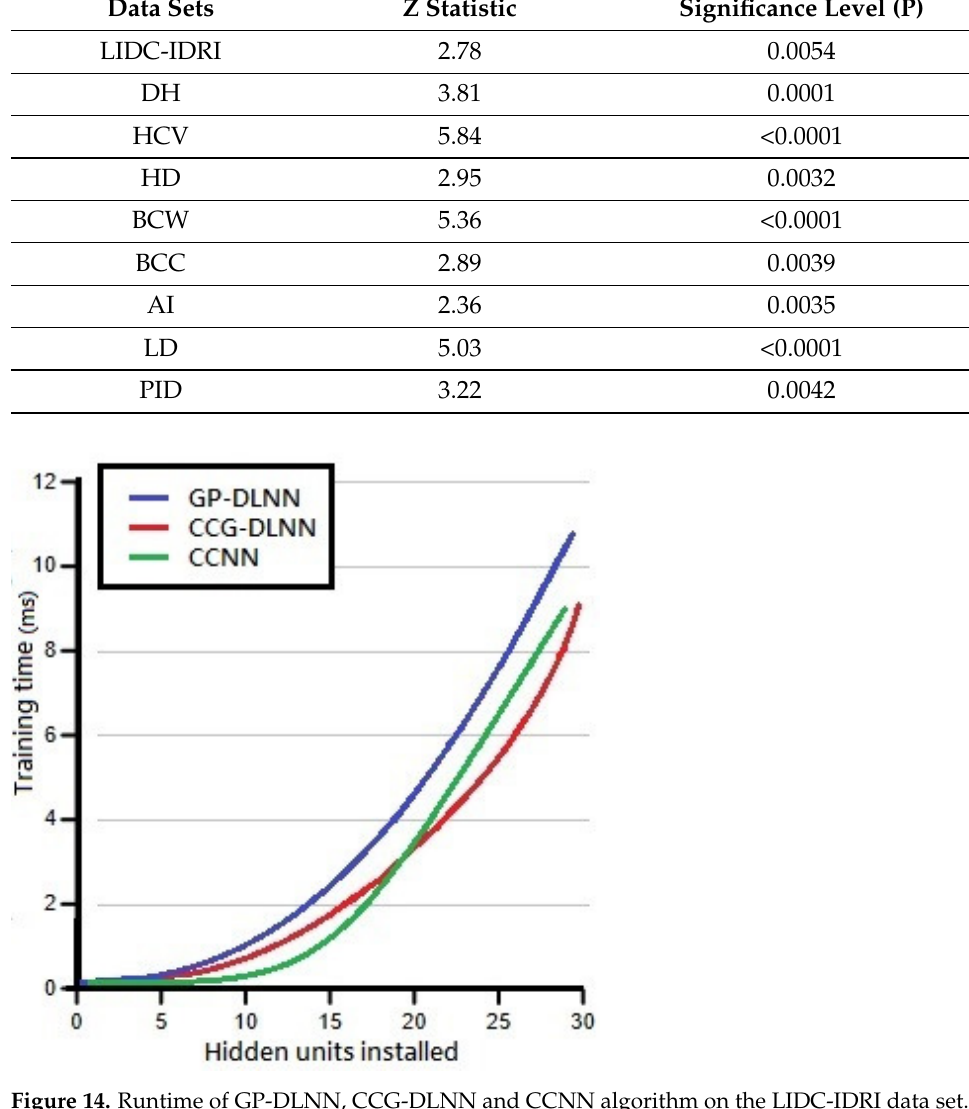
Figure 14. Runtime of GP-DLNN, CCG-DLNN and CCNN algorithm on the LIDC-IDRI data